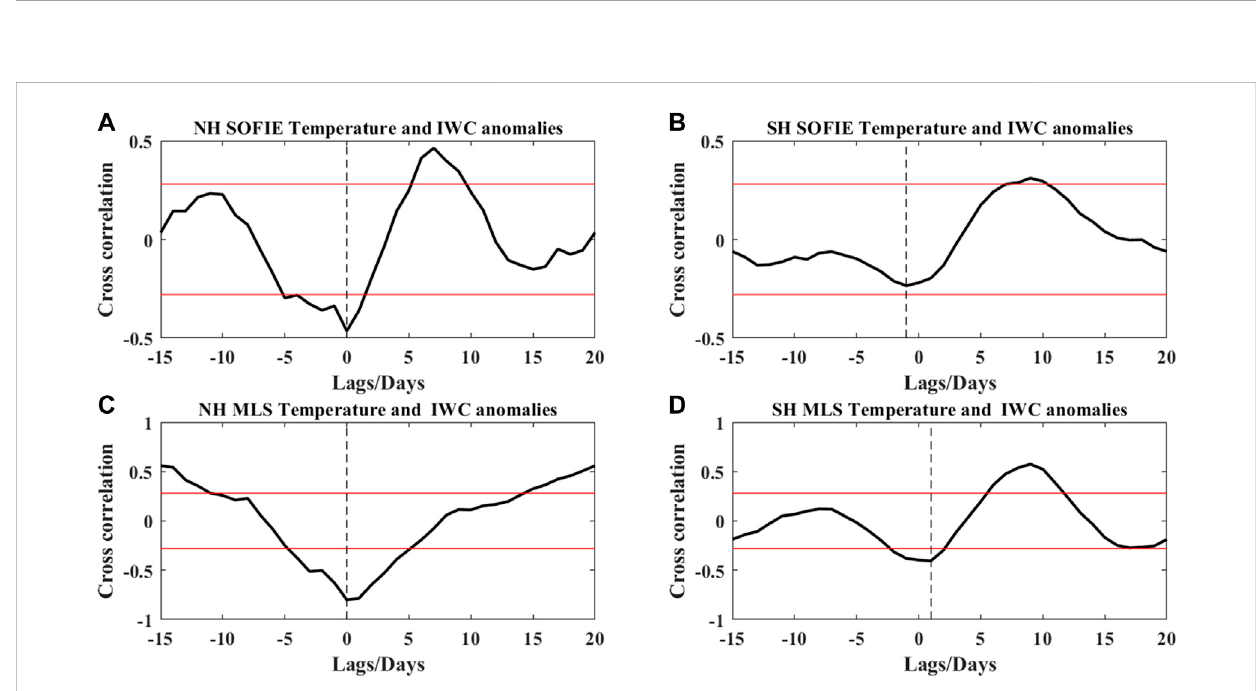
FIGURE 4 (A) Correlation curve of SOFIE temperature anomaly and IWC anomaly in the NH calculated by SEA. (B) Correlation curve of SOFIE temperature anomaly and IWC anomaly in the SH. (C) Correlation curve between MLS temperature anomaly and IWC anomaly in the NH. (D) Correlation curve between MLS temperature anomaly and IWC anomaly in the SH. Red lines correspond to the correlation coef fi cients with statistical signi fi cance equal to